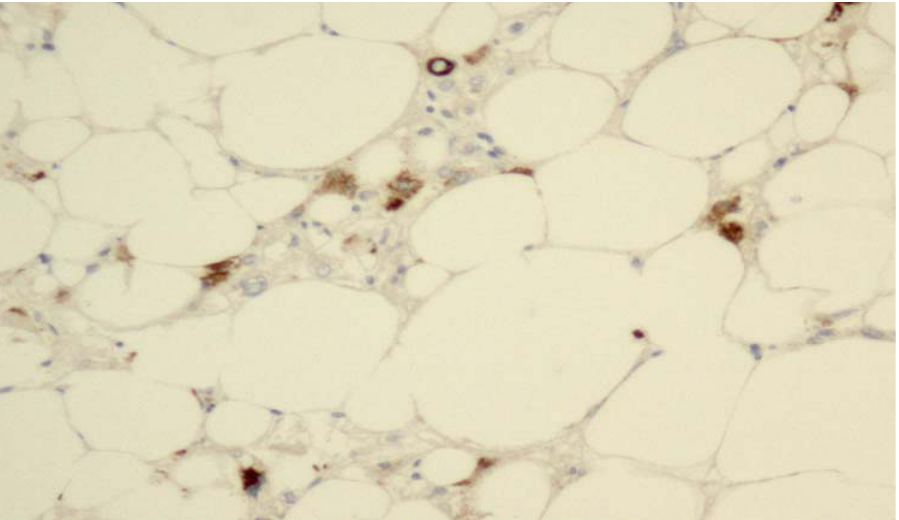
FIGURE 4. HMB-45